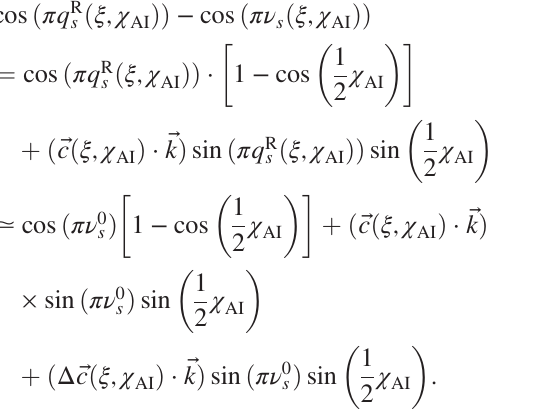
( i ¼ 1 , 2, 3) for i